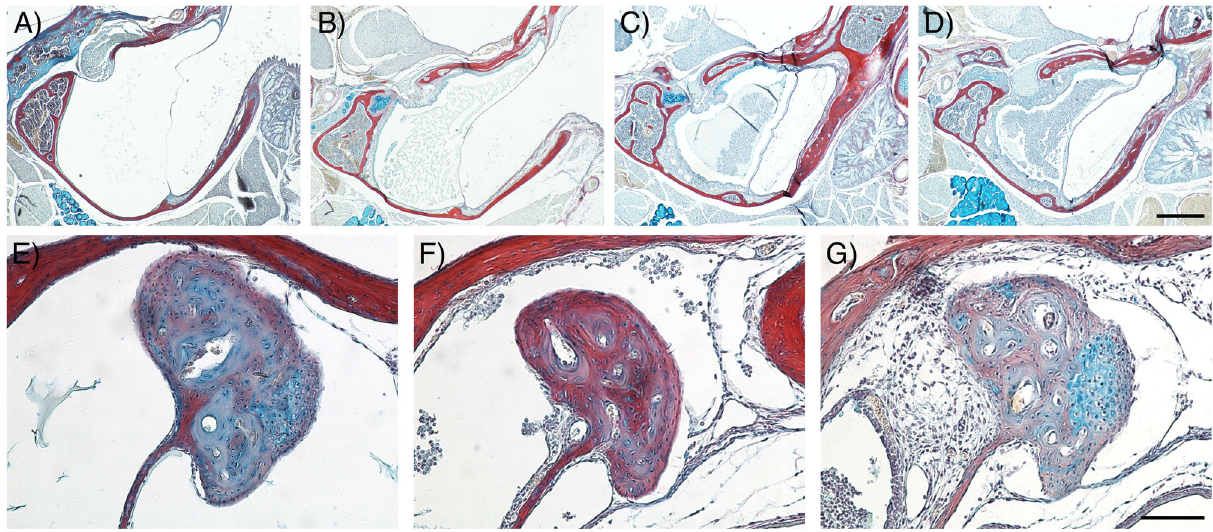
Figure 4. The severity of OM correlates with the degree of hearing loss in Df1/+ mice (see also Table 1). (A-G) Frontal trichrome-stained sections from adult mice showing the graded severity of effusion in Df1/+ middle ear cavities (A-D) and thickened mucosa around the head of the malleus (E-G). Least severe conditions are displayed on the left hand side panels with increasing severity towards the right hand side panels. (A) No effusion, (B) serous effusion, (C) effusion with <50% infiltrated cells and (D) effusion with >50% infiltrated cells. (E) No thickening, (F) mild thickening and (G) severe thickening of the mucosa around the head of the malleus. Dorsal is top. Scale bar: 500 μm (A-D), 100 μm (E-G). doi: